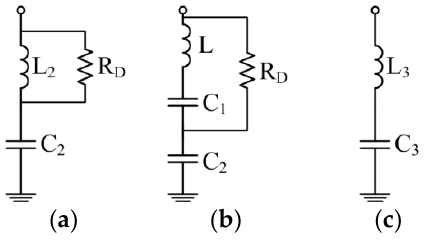
Figure 2. Typical second and third harmonic passive filter topologies ( a ) single-tuned damped second HF; ( b ) C-type third HF; and ( c ) single-tuned undamped third HF. Table 1. EAF and supply-side current components of second harmonic subgroup for the block diagram in Figure 1 for various filter topologies.